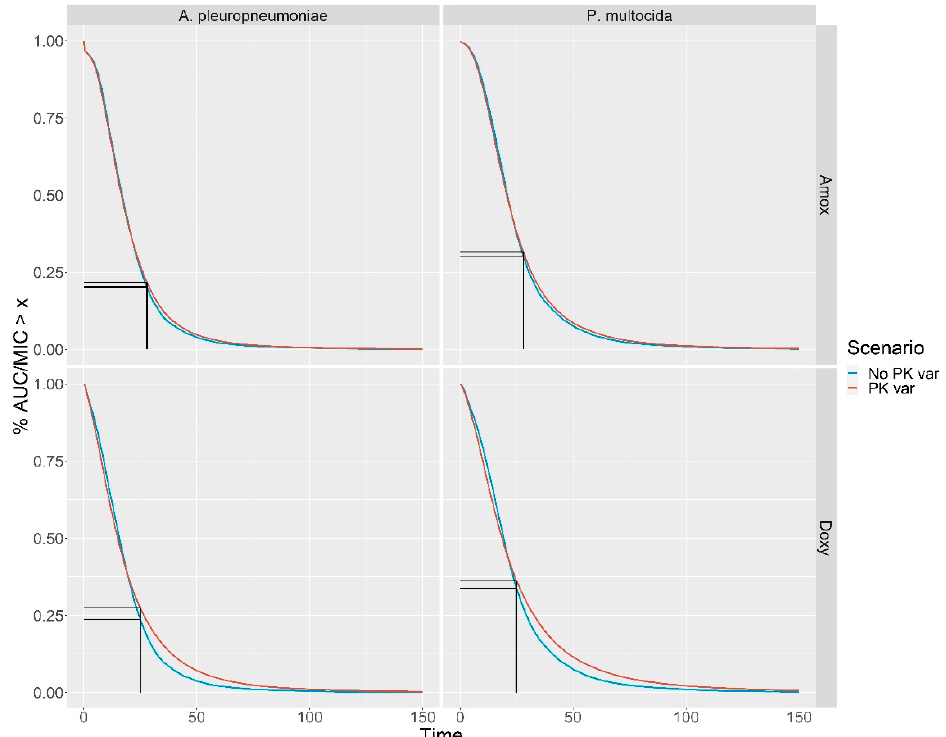
Figure 3. Survival function of the AUC/MIC ratio for amoxicillin (top) against P. multocida (left) and A. pleuropneumoniae (right) and for doxycycline (bottom) against P. multocida (left) and A. pleuropneumoniae (right). The vertical lines correspond to the threshold for bacteriostatic effect (28 h for amoxicillin and 25 h for doxycycline). At best, 36% of the piglets have an AUC/MIC ≥ 25 (doxycycline VS P. multocida ).